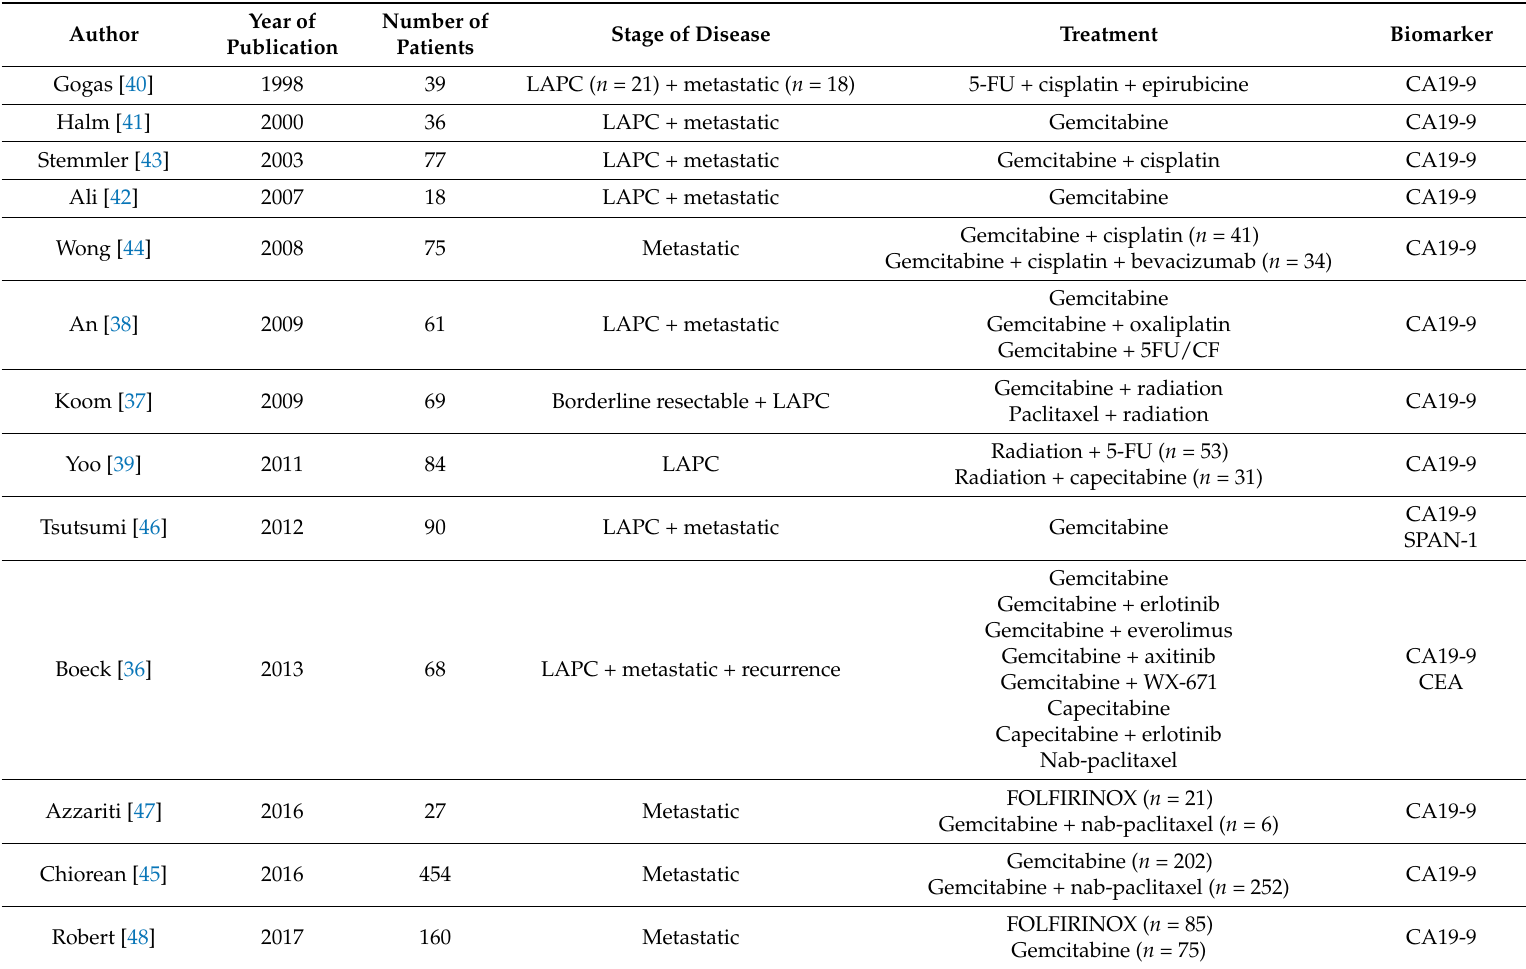
Table 1. Overview of studies including conventional tumor markers as predictive biomarkers for chemotherapy response in pancreatic cancer